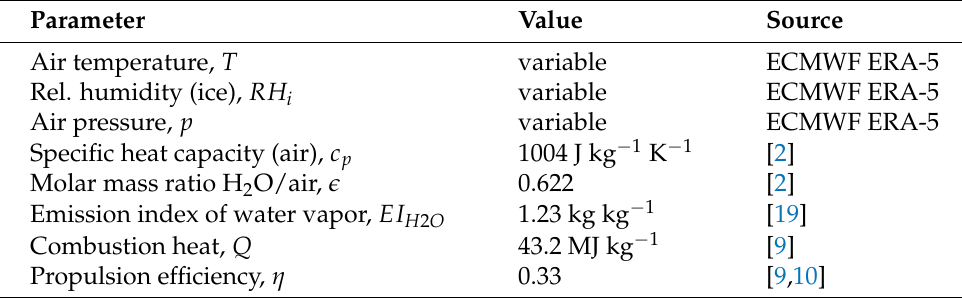
Table 1. Parameters used for the calculation of the Schmidt–Applemann